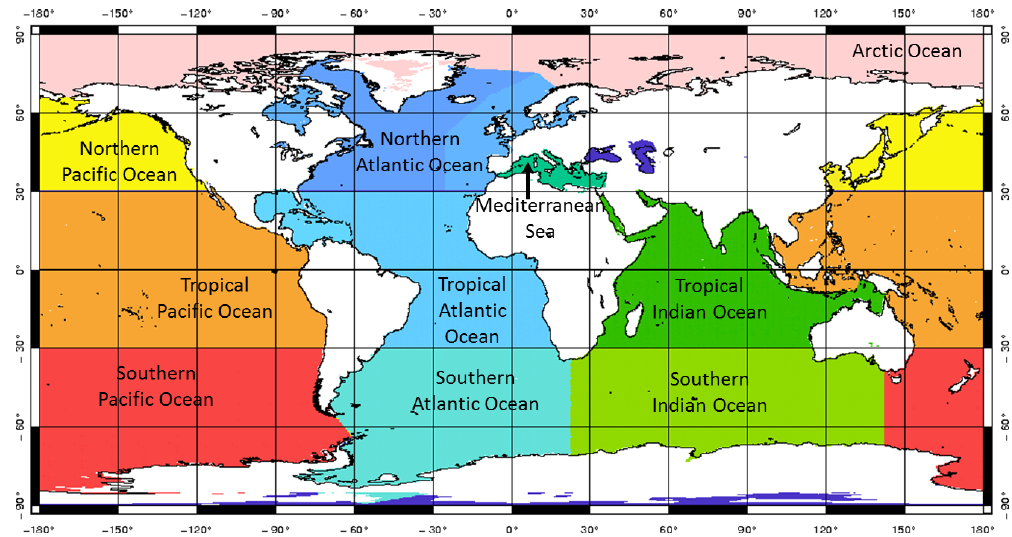
Figure 7. Divisions used for the perturbations of the wave drag